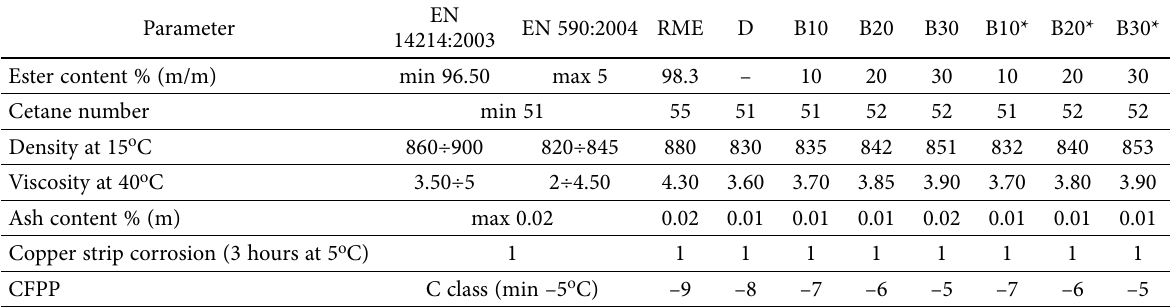
Table 3. Physicochemical characteristics of multicomponent fuels and limit values of